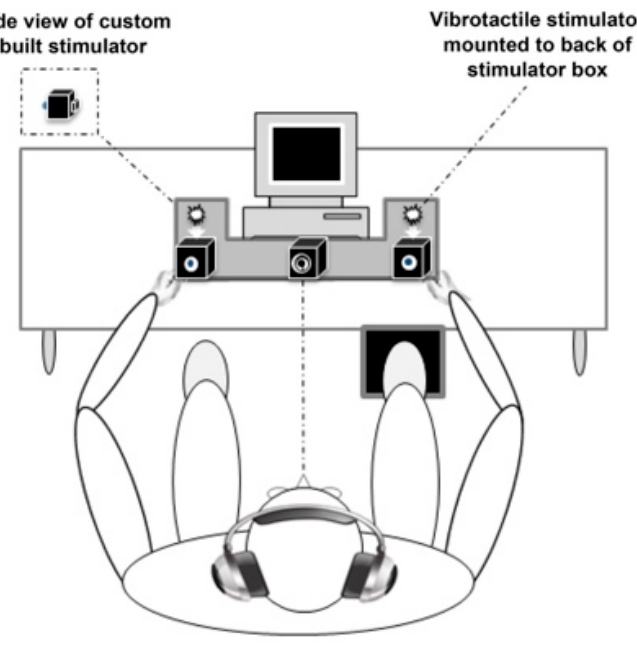
Figure 1. Experimental Apparatus.